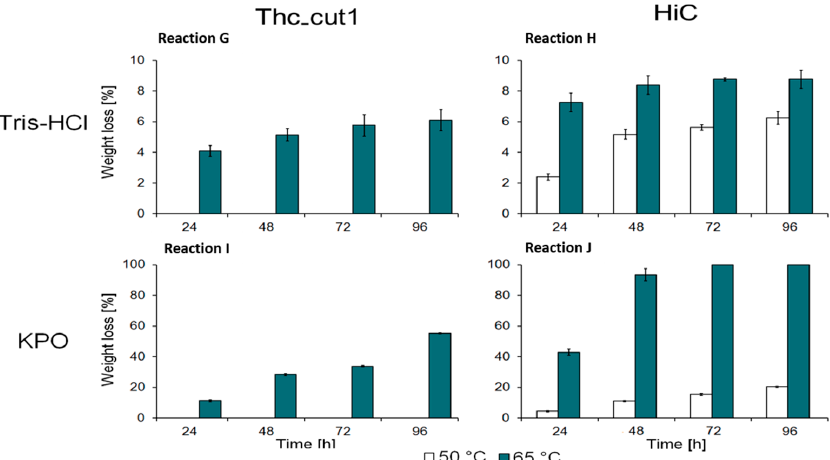
Figure 3. Enzymatic hydrolysis of amorphous PEF films. Time course reaction showing the weight loss for the enzymatic hydrolysis performed at 50 (white bars) and 65 °C (green bars) with Thc_cut1 (reaction G, reaction I) and HiC (reaction H, reaction J) in 0.1 M Tris ‐ HCl pH 7 (reaction G, reaction H) and 1 M KPO pH 8 (reaction I, reaction J). No detectable changes of the weight were detected in reactions G and I when performed with Thc_cut1 and control reactions. All experiments were performed in triplicate.